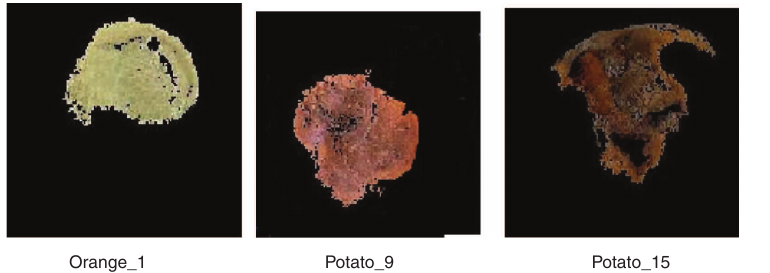
Figure 8: Images of the Segmented